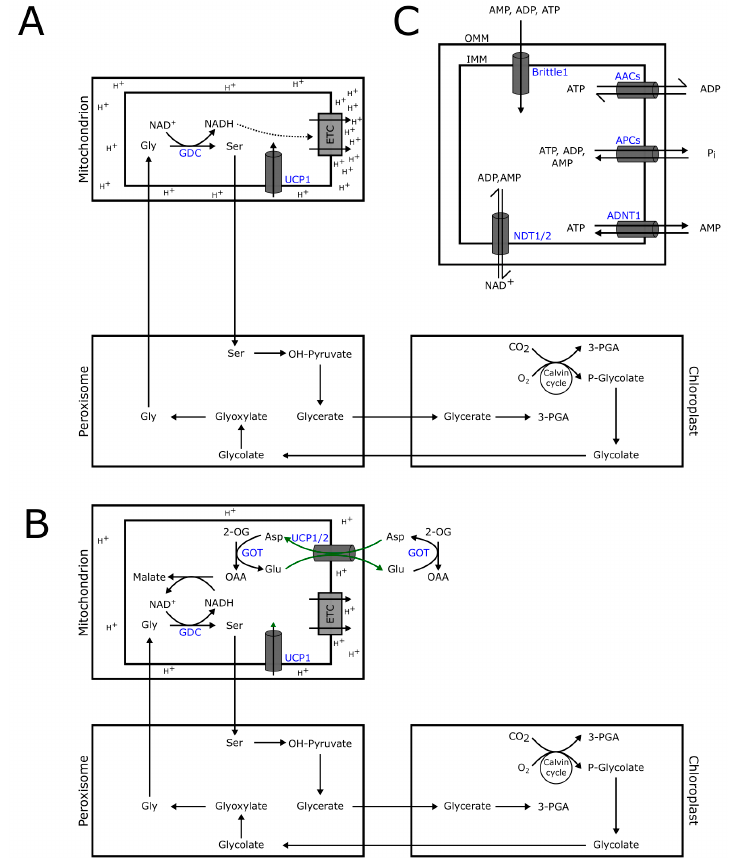
Figure 3. Mitochondrial carriers relevant to mitochondrial oxidative phosphorylation. ( A ) Sweetlove